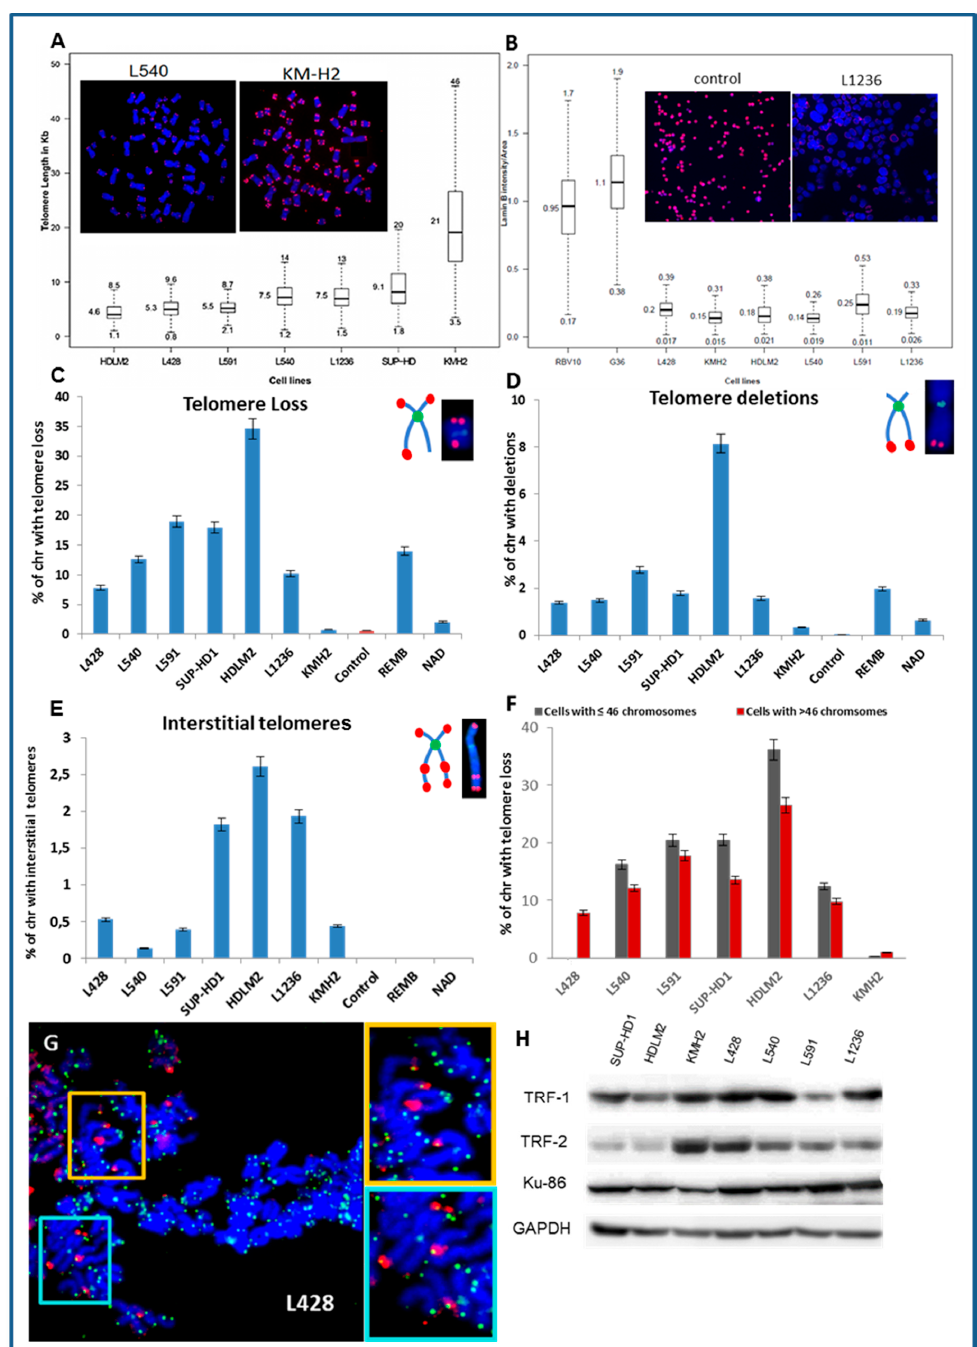
Figure 1. Telomere dysfunction in Hodgkin lymphoma (HL) cell lines ( A ) Quantification of telomere length by teloquant-Q-FISH with specific PNA probes. In the box plots of telomere length, the midline reflects the median, the box length the interquartile range (interquartile range, 25th to 75th percentile), and the whiskers the 5th and 95th percentiles. The Min and Max values are presented. The images are of an L540 metaphase with short telomeres and one of KMH2 with long telomeres (63× magnification). ( B ) Box plots of the fluorescence intensity of Lamin B1 protein in HL cell lines and control lymphoblastoid cell lines RV10 and G36. The midline reflects the mean intensity. An image of the fluorescent signal of lamin B1 in nuclei of L1236 HL cells and control cells is presented (10 ×